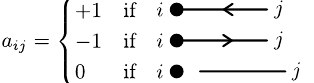
Figure 27: A graph can be represented in terms of the incidence matrix defined